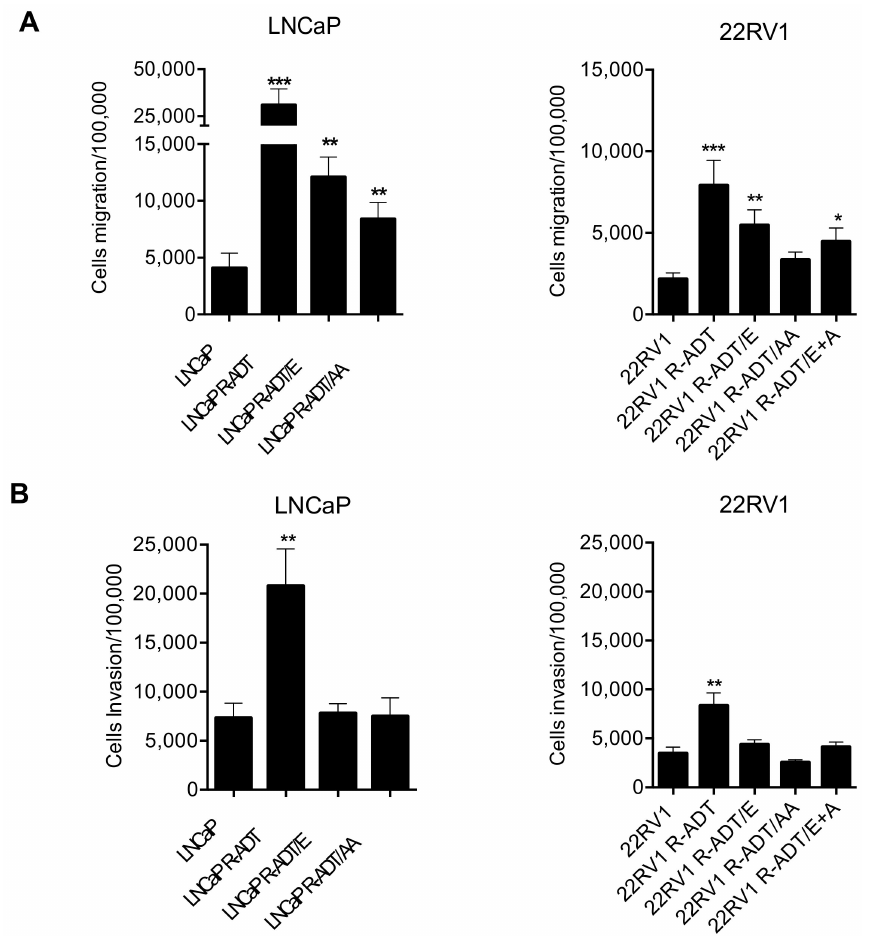
Figure 6. Analysis of migration and invasion assays in the resistant lines derived from LNCaP and 22RV1. ( A ) Migration assays in LNCaP (left panel) and 22RV1 (right panel). ( B ) Invasion assays in LNCaP (left panel) and 22RV1 (right panel). In both sections the histograms represent the number of cells that migrate or invade per 100,000 cells seeded. Data shown correspond to the mean ± SD calculated from the triplicates made for each condition. (* p < 0.05; ** p < 0.01, *** p < 0.001, t -Student test). The significant differences shown are with respect to the wild-type cell